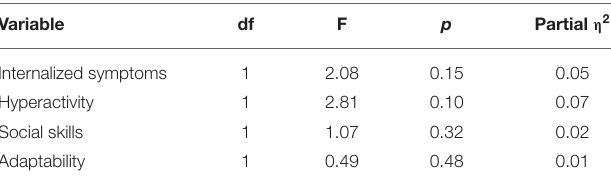
TABLE 3 | Results of ANCOVA for internalized symptoms, hyperactivity, social skills and adaptability. Variable df F p Partial η